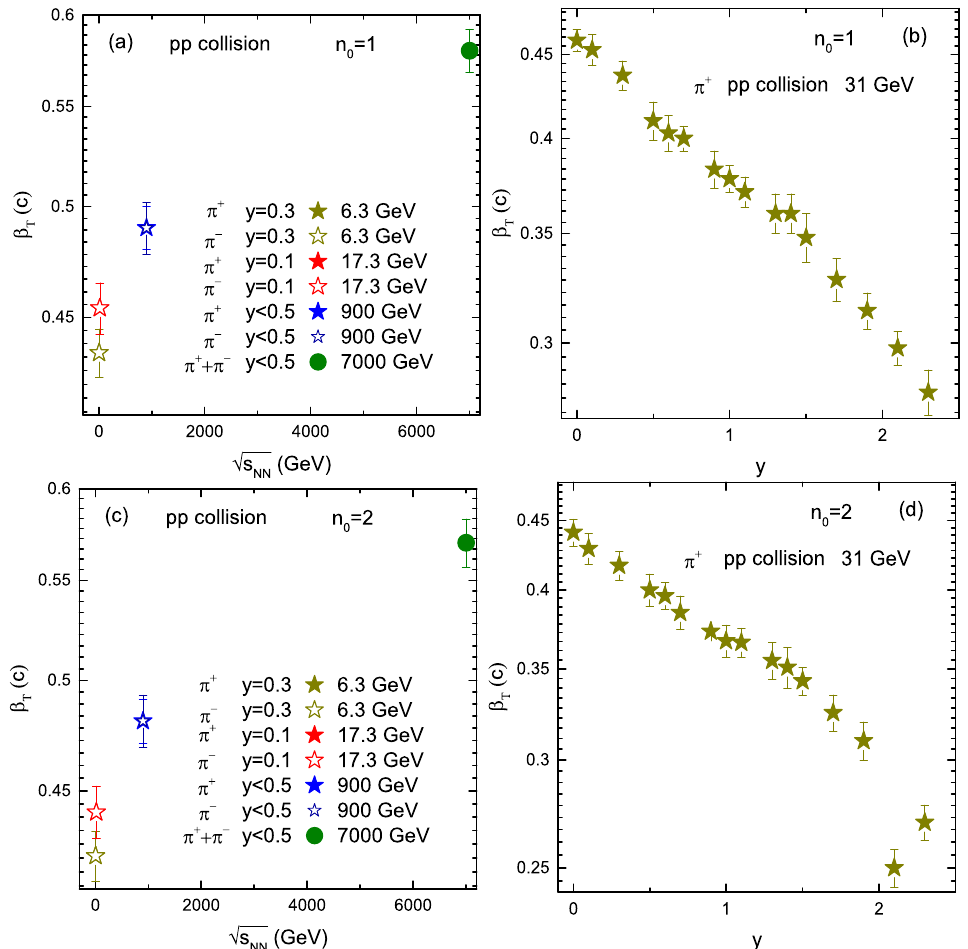
Figure 3. Dependence of transverse flow velocity on collision energy and rapidity at 31 GeV. Panels ( a , c ) show the dependence of β T on collision energy by interpreting n 0 = 1 and 2, respectively, in the TBW model, while panels ( b , d ) show its dependence on rapidity at 31